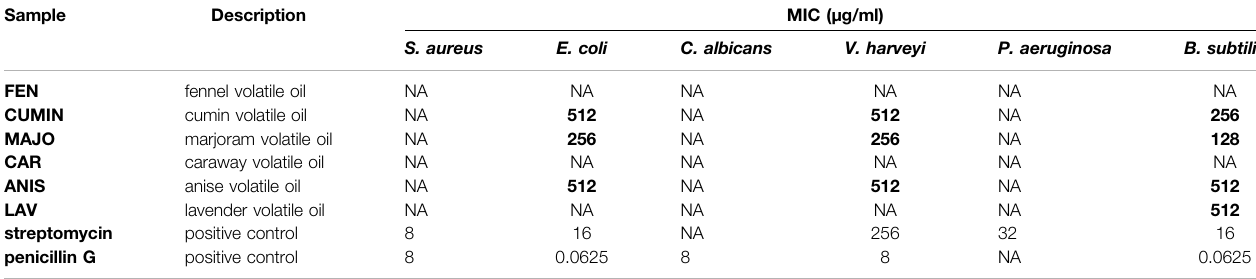
TABLE 2 | Antimicrobial effects of volatile oils on six different bacterial strains.